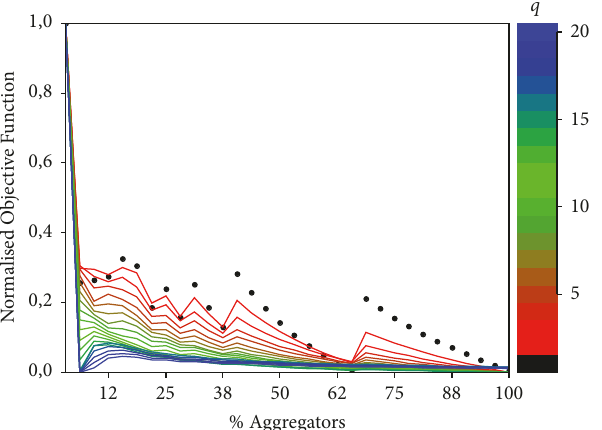
Figure 7: Bus-to-aggregator map efficiency. The normalised value of 𝑧 for the optimal solution is shown for different number of aggregatorsand 𝑞 .Blackcirclesrepresentfeasiblesolutionsfor 𝑞 = 0 .